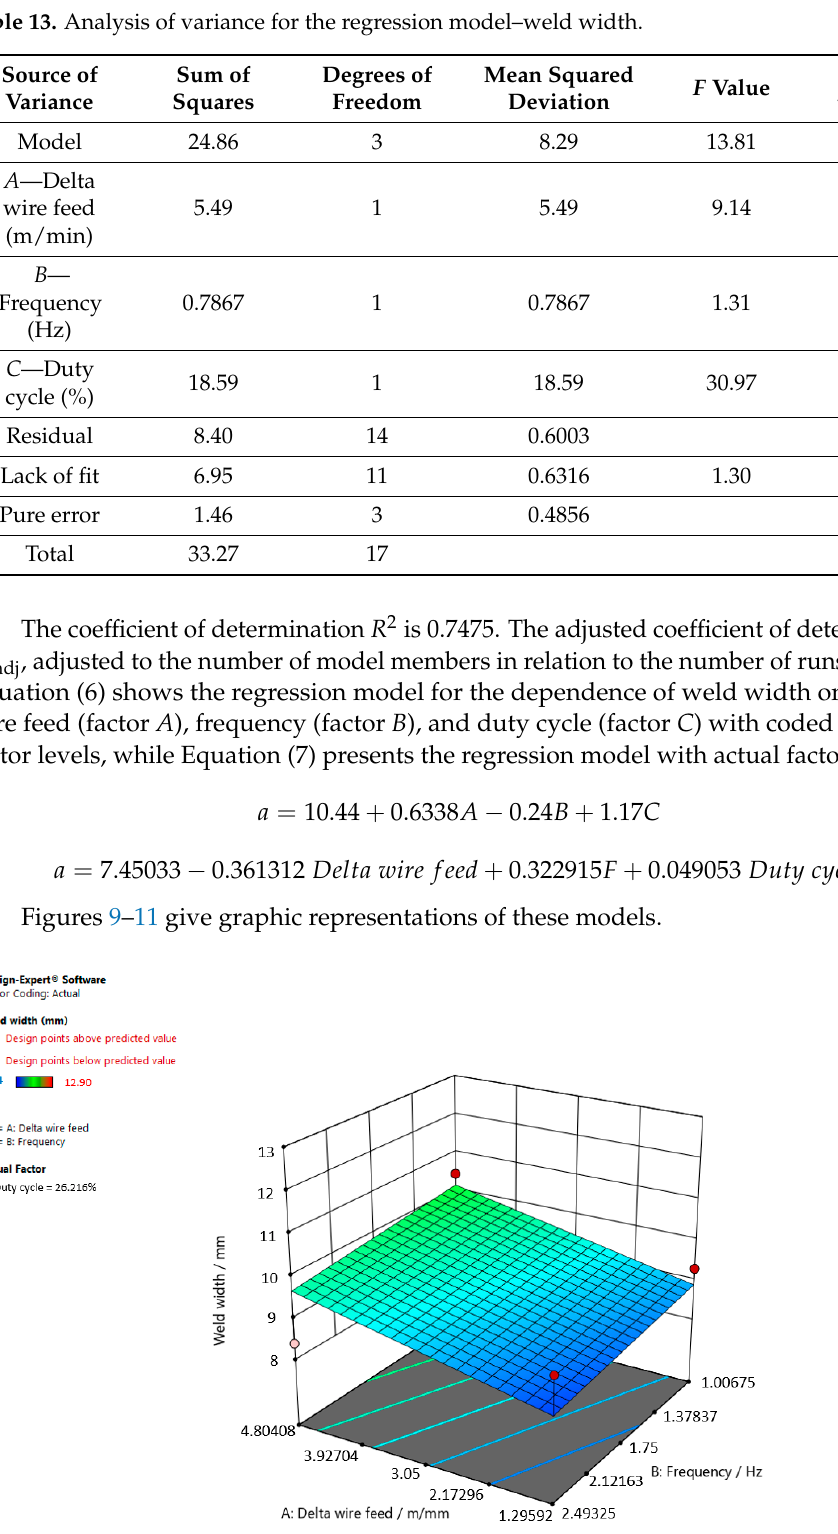
Figure 10. Response surface for the regression model of weld width at a duty cycle of 50.00%. Figure 10 shows that the weld width increases, the delta wire feed parameter in- creases, and the frequency slightly decreases when the duty cycle is 50.00%.